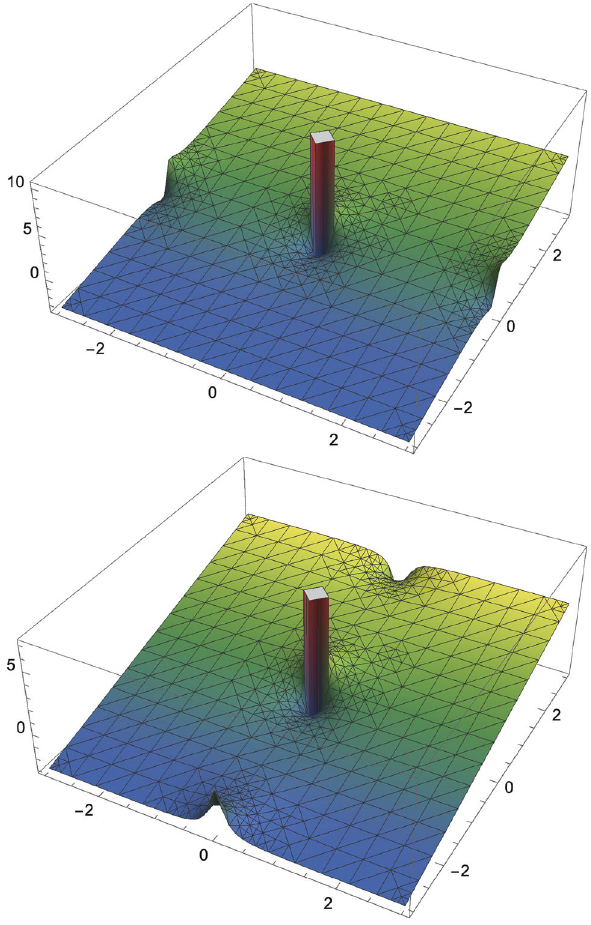
(cid:18) (cid:19) ( N ) iS saddle 0